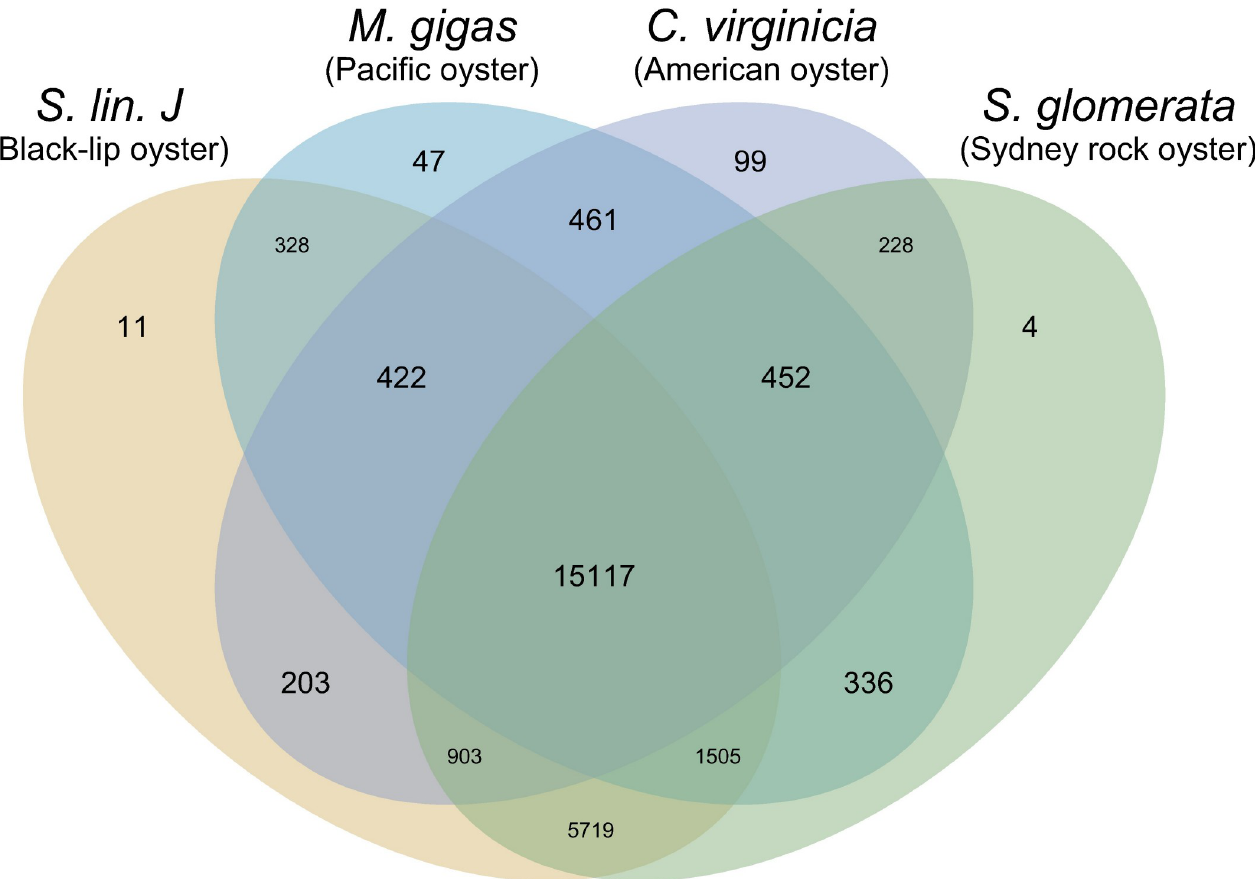
Fig 3. Patterns of gene orthology in oyster species. Number of orthogroups shared between Saccostrea lineage J , Saccostrea glomerata , Magallana gigas , and Crassostrea virginica . 15117 orthogroups are shared between all four species, and 5719 orthogroups are shared exclusively between the two Saccostrea species.